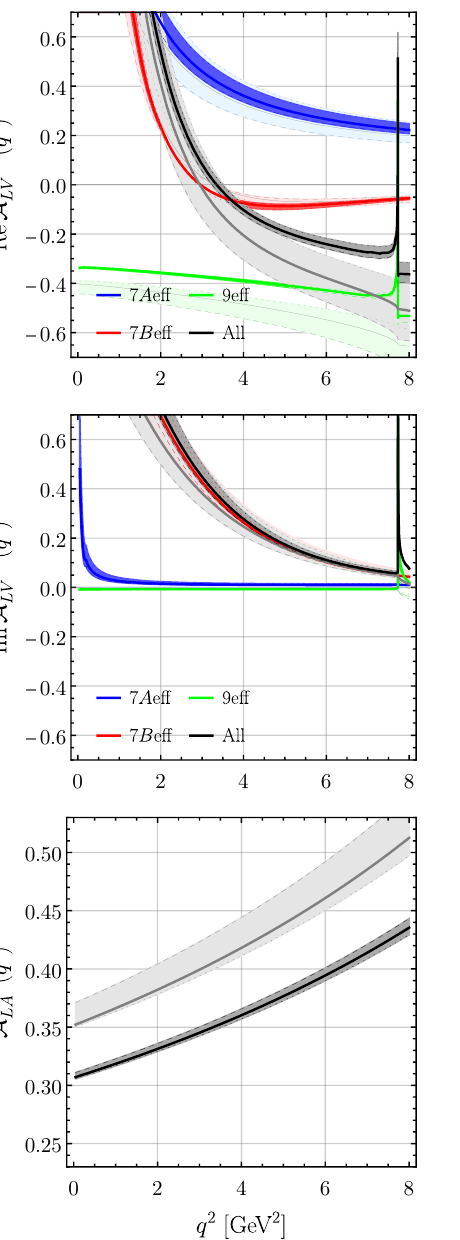
Figure 4 . The µ h [left] and µ hc [right] dependence of the helicity amplitudes Re A LV [upper], Im A LV [middle] and A LA [lower] at LP. The variation of µ h = { 2 . 5 , 5 . 0 , 10 . 0 } GeV and µ hc = { 1 . 0 , 1 . 5 , 2 . 0 } GeV [dotted, solid, dashed] leads to the grey bands at LO QCD [lighter] and NLO QCD [darker]. The individual contributions i = 7 A, 7 B, 9 [blue, red, green] are shown for A LV